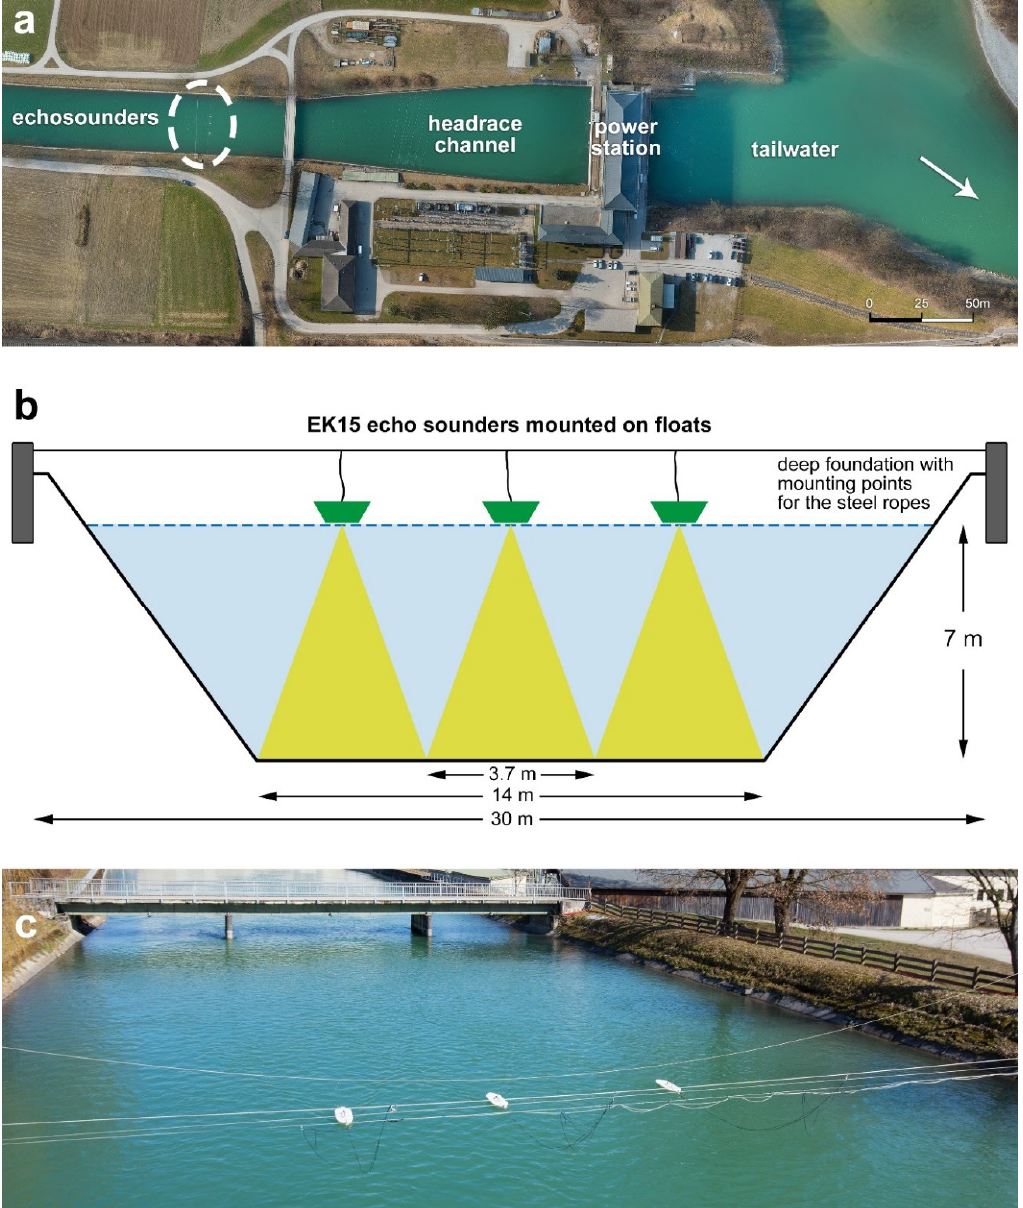
Figure 2. Overview of the headrace channel with the installation of the EK15 sounders indicated, the power station itself and the tailwater ( a ) Plan view using an orthoimage of the site (photo: droneproject.at). ( b ) Schematic cross‐section through the headrace channel, showing the setup of the EK15 echosounders. ( c ) Image of the installation, facing into flow direction.